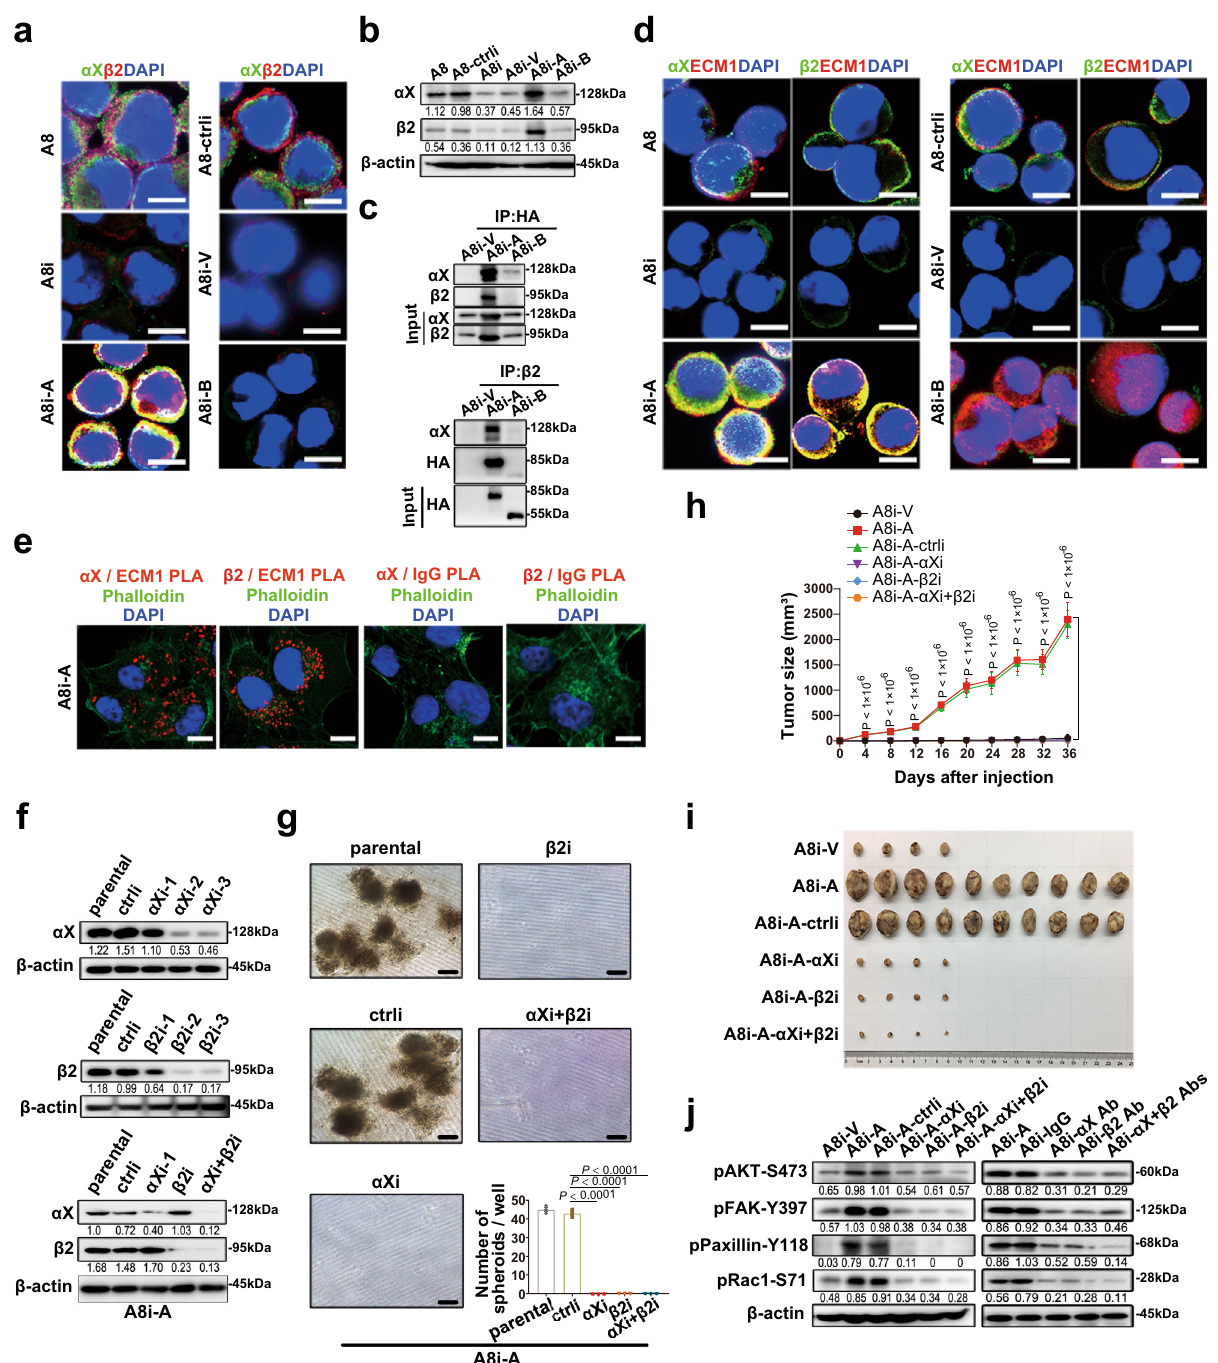
Fig. 2 Interaction of ECM1a with integrin α X β 2. Protein colocalization or expression of integrins α X and β 2 in A8, A8-ctrli, A8i, A8i-V, A8i-A, and A8i-B cells as detected by IF ( a , bars = 10 µ m) or WB analysis ( b ). Interactive binding of ECM1a or ECM1b with integrin α X and/or integrin β 2 as detected by co-IP ( c ), IF ( d ), and PLA ( e ). Bars = 10 µ m. Silencing of integrin α X and/or integrin β 2 with speci fi c shRNAs ( f ) altered in vitro cell 3D growth ( g , bars = 400 μ m, quanti fi cation data are presented as mean ± SD, n = 3 biologically independent repeats, two-tailed t -test), tumor growth ( h , data are presented as mean ± SD, n = 10v10 mice, two-tailed t -test) and tissues ( i ) in ten mice. j Detection of cellular signaling molecules associated with ECM1 in cells expressing shRNAs against integrin α X, β 2, or α X β 2 (left panel) or in cells pretreated with antibodies against integrin α X, β 2, or α X β 2 (right panel). fi brinogen α chain (FGA) 19 , whereas the fi brinogen γ chain (FGG) β 1, JUP, annexin A2, calnexin, and S100A9, although it may competitively inhibit the binding of ECM1a to plakophilin-1 and may also be recognized by integrin α X β 2 on leukocytes 20,21 . Two S100A8. different studies have found that ICAM-1 may be recognized by α X or β 2 of α X β 2 22,23 , and iC3b has been reported to bind with Loike et al. reported that CD11c/CD18 (integrin α X β 2) on tumor necrosis factor-stimulated neutrophils may function as a the α X subunit of integrin α X β 2 on erythrocytes 24 , on neutrophils fi brinogen receptor by binding with the GPR sequence in the and monocytes 25 and on alveolar macrophages 26 . However, NATURE COMMUNICATIONS| (2021) 12:4230